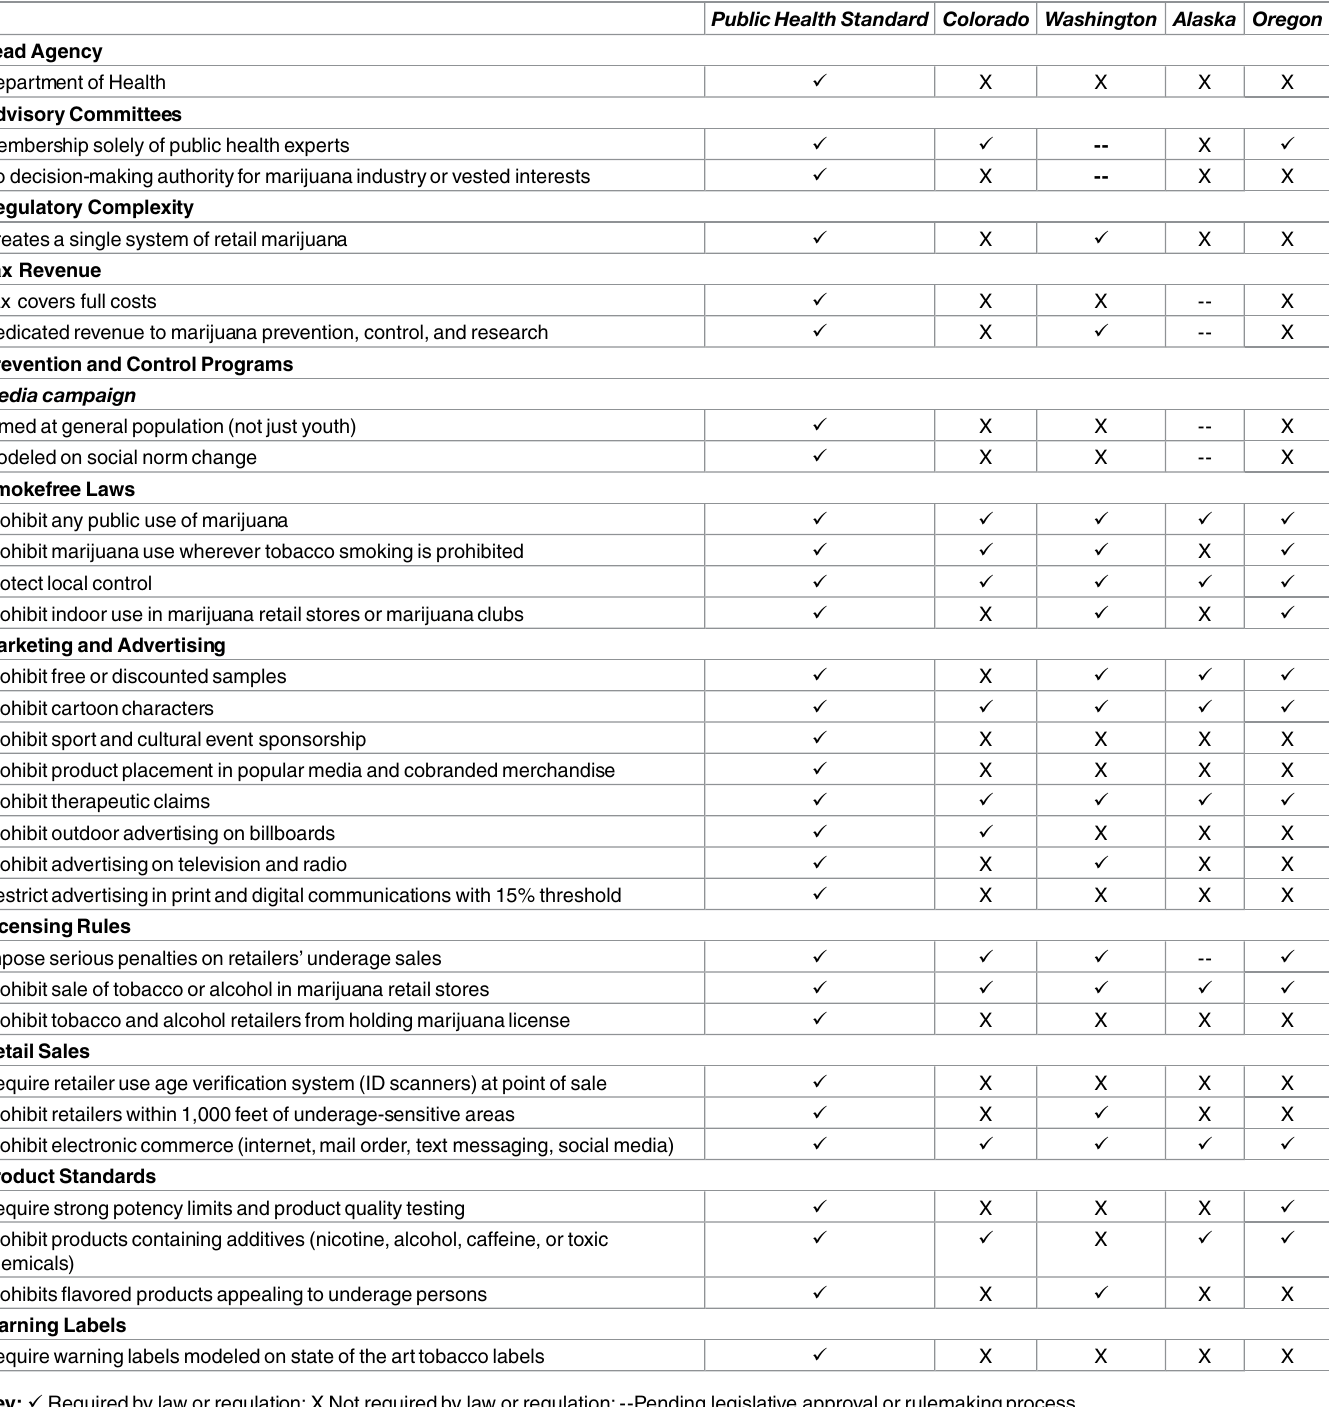
Table 1. Public healthframework versus